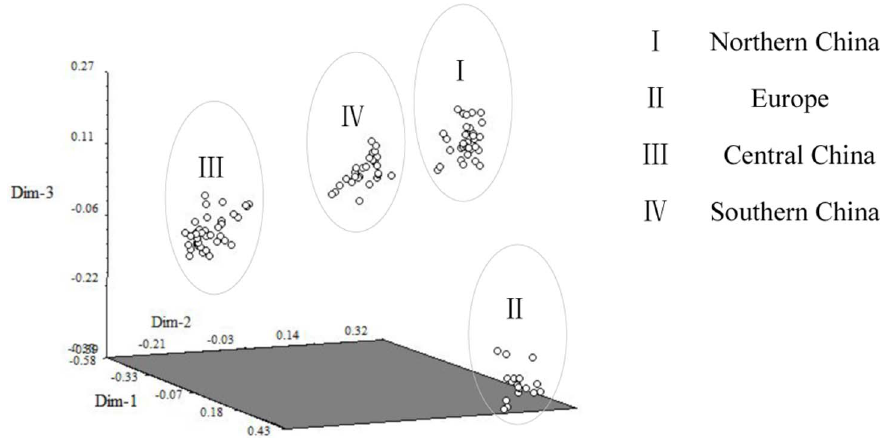
Figure 3. Principles coordinate analysis for SSR markers using the genetic similarity matrix for 115 cannabis varieties.